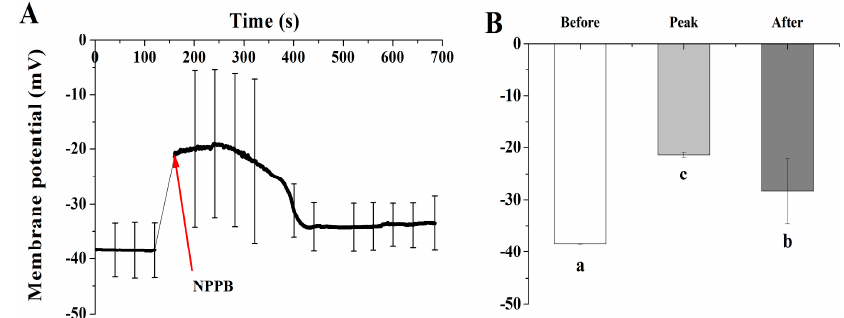
Figure 7. Effect of NPPB on the membrane potential in tea root mature zone cells. ( A ) The kinetics of plasma membrane potential in tea root mature zone cells treated with NPPB; ( B ) Plasma membrane potential at state of before (0 to 120.75 s, without 50 µM NPPB), peak (160 to 300.96 s, with NPPB), and after (120.75 s, with NPPB). Data indicate mean ± SD ( n = 8). Error bars indicate the difference among the treatments and different low case numbers near the chart bars indicate the level of significant difference compared with control at p < 0.05.